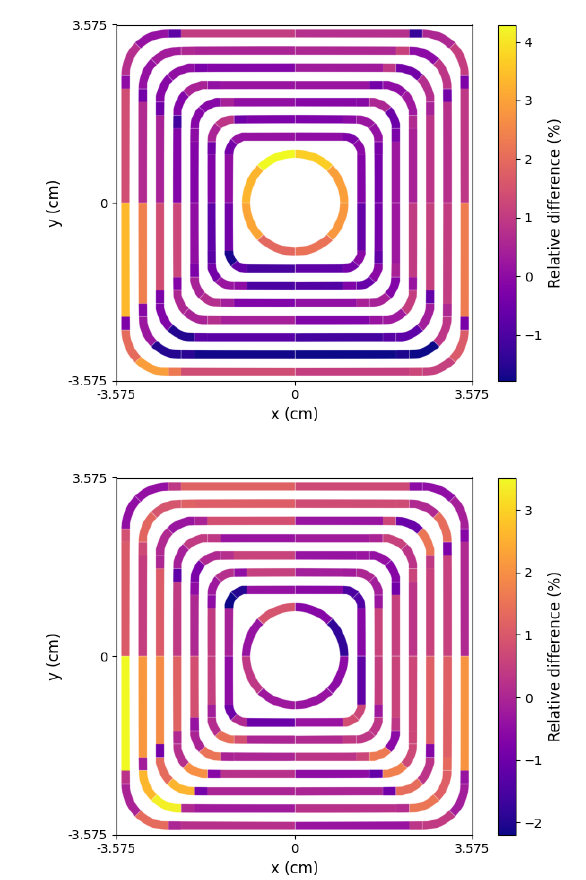
Figure 5. Relative differences between RBF-based power reconstruction and reference data for Cartesian meshes 9 × 9 (top) and 17 × 17 (bottom), both for fuel assembly in